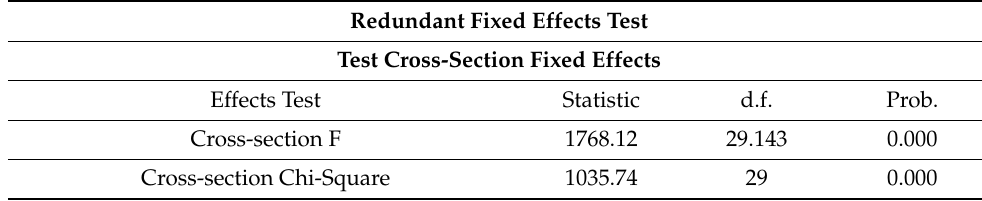
Table 6. Redundant fixed effects tests.